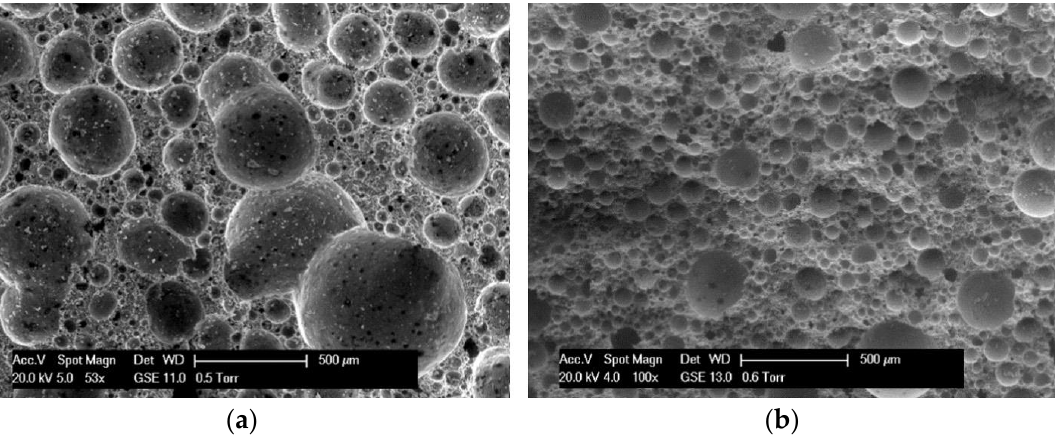
Figure 8 . SEM images of foamed concrete (( a ): concrete density = 500 kg/m 3 , ( b ): concrete density = 1000 kg/m 3 ). Reprinted/adapted with permission from Ref. [117]. 2013, Elsevier Science &Technology Journals.